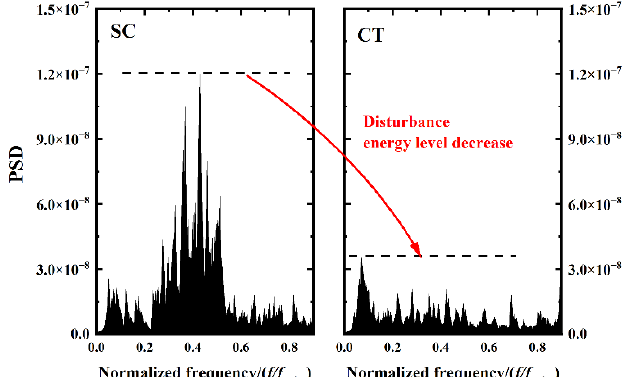
Figure 12. Comparison in PSD spectrum of C 1 in SC and CT.